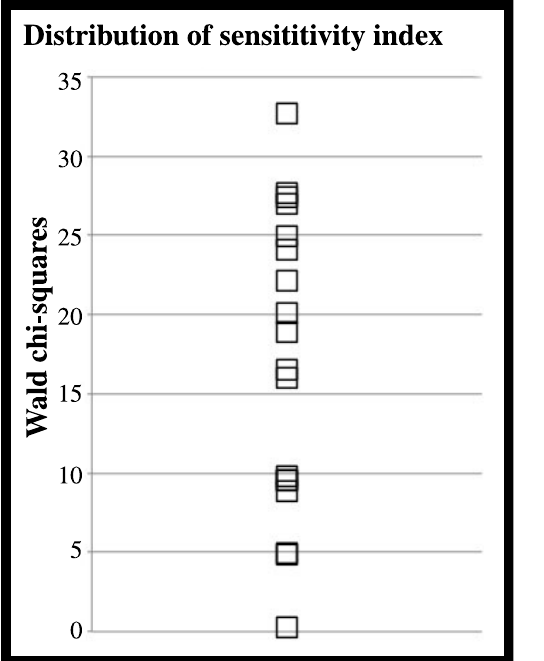
Fig 2. Distribution of sensitivity coefficients for speech sounds. A. Scatterplot illustrating the distribution of the Wald chi-square statistics for speech.